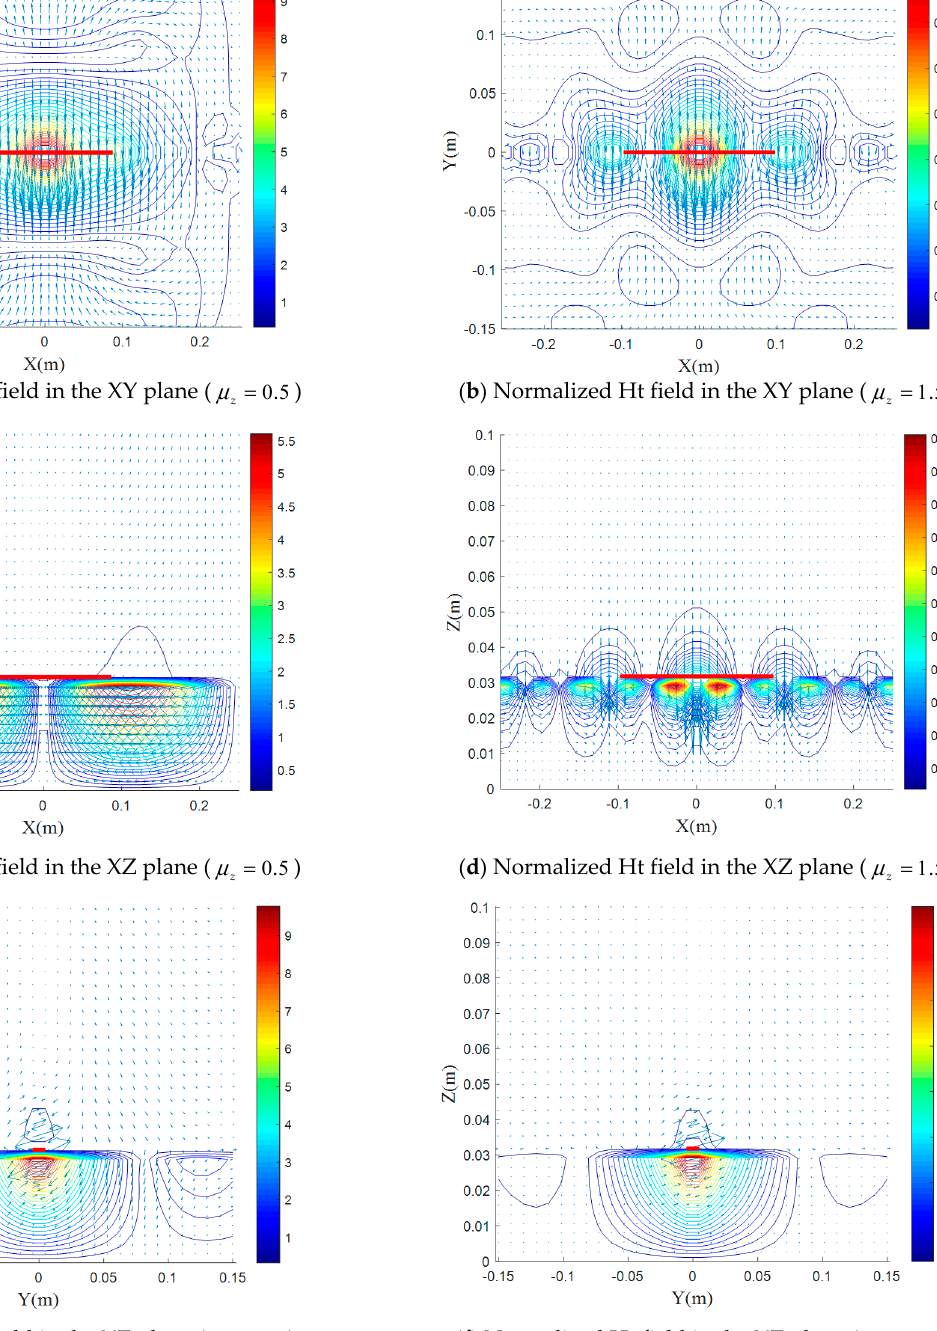
μ with 253 . == εε and 1 = μ , in the z tz t